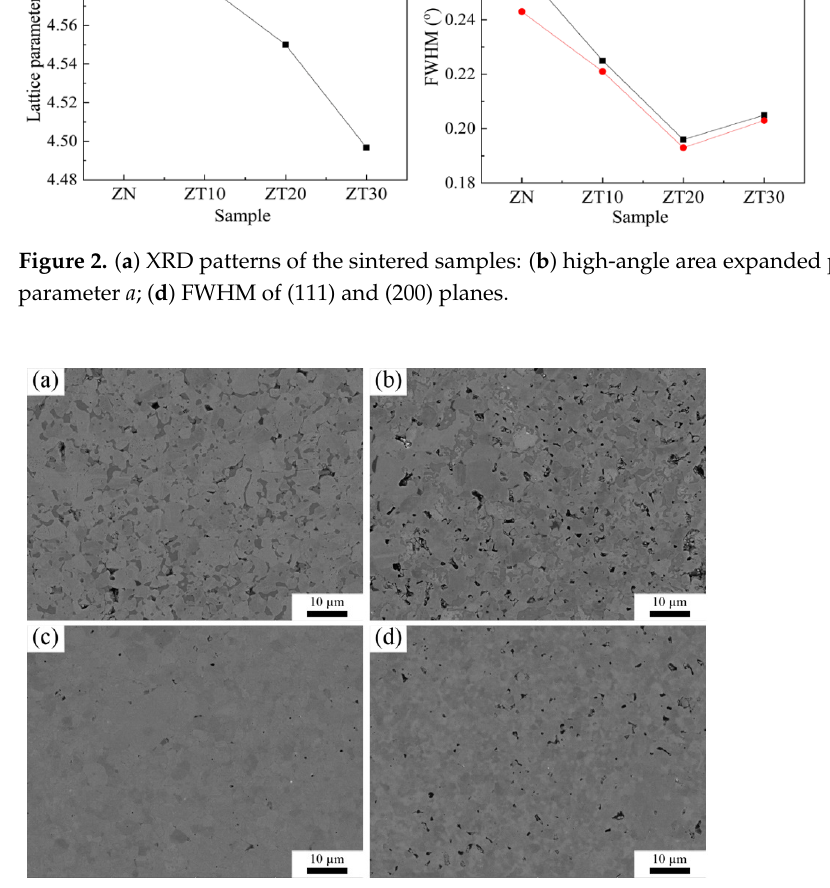
Figure 4. ( a ) BSE image of sample ZT10, ( b )–( d ) EDS mapping of N, Ti, and Zr, ( e ) and ( f ) EDS spectra of spots 1 and 2, respectively. Figure 5 shows the typical fracture surfaces of sintered samples. Notably, some tiny round pores were observed in all samples, which was mainly due to the rapid grain boundary migration caused by the high heating rate [25]. From the fracture morphologies of as-prepared ceramics, no pores can be found. The fracture surface of monolithic ZrN ceramic shows apparent smooth and cleavage surfaces, which indicates that intergranular and transgranular fracture modes coexist. As can be observed in Figure 5a,b, the morphol- ogy of the fracture surface of sample ZT10 was similar to that of sample ZN. For sample ZT20, most grains had smooth surfaces, indicating that the fracture mode was dominated by transgranular fracture. In Figure 5d, the morphology of the fracture surface was obvi- ously changed. Furthermore, the fracture mode of ZT20 and ZT30 demonstrated a low